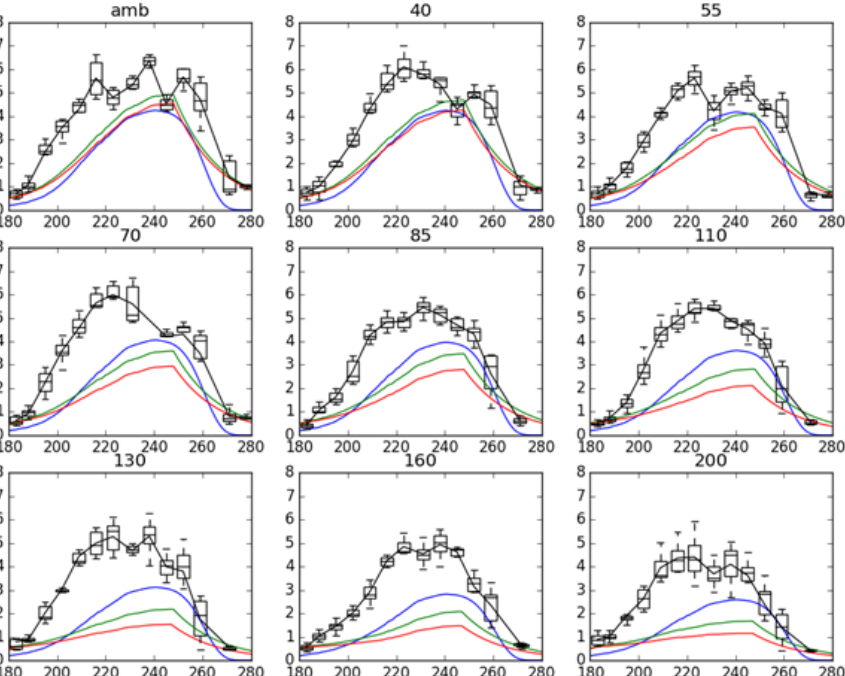
Figure 5. Time series of leaf area index (LAI) responses on different target ozone concentration at SoyFACE. Black line is observed LAI from Betzelberger et al. (2012), and the other lines are JULES-crop LAI with different tunings. Blue: calibrated JULES-crop using Mead observations. Green: Osborne 2015 tuning with low sensitivity. Red: Osborne 2015 tuning with high sensitivity to